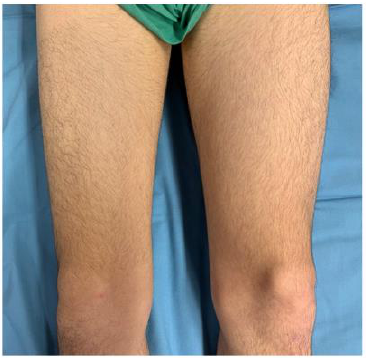
Figure 1. Notable atrophy of the anterior thigh muscle mass of the right lower extremity as a consequence of its long-term load relief due to peristent pain.